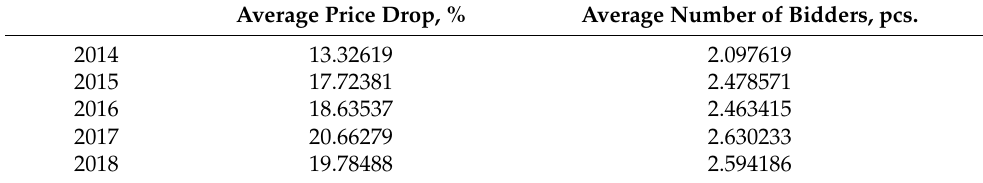
Table 4. Borders of proposed groups. Average Price Drop, % Average Number of Bidders, pcs.